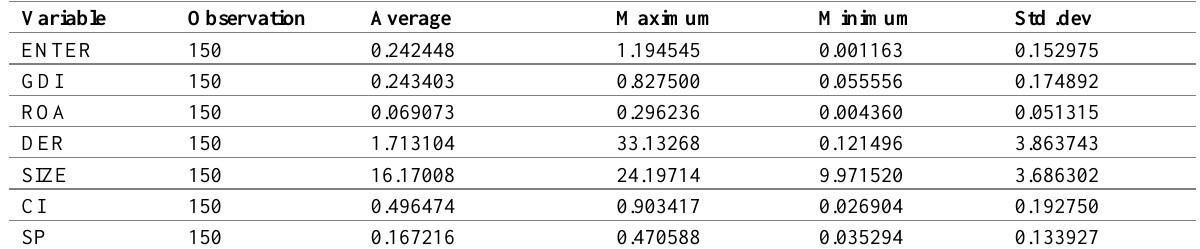
Table 3: Descriptive Statistics